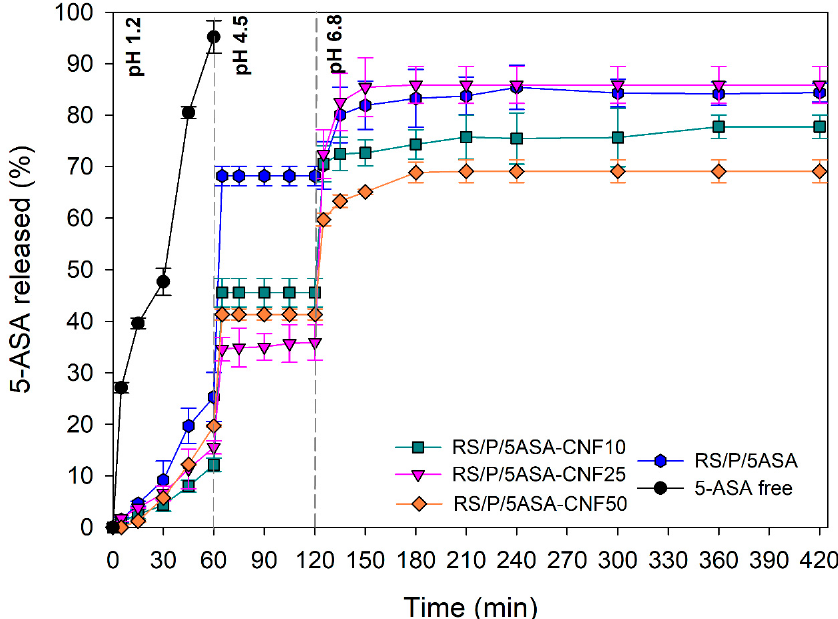
Figure 7. In vitro 5-ASA release profiles from spray-dried microparticles in media with different pH values, mimicking gastric (0–60 min; pH 1.2), duodenal (60–120 min; pH 4.5) and colonic (120–480 min; pH 6.8) phases. Each value represents the mean ± standard deviation, n = 3.